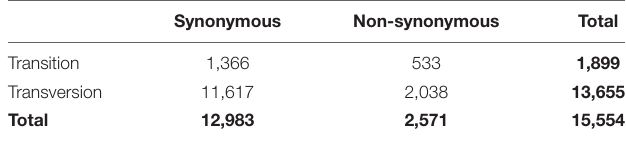
TABLE 4 | Single nucleotide polymorphisms (SNP’s) present in protein coding genes of P. indicus